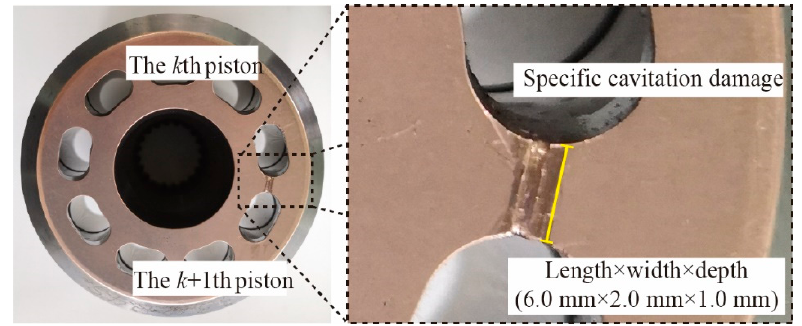
Figure 5. Valve plate pair with specific cavitation damage.